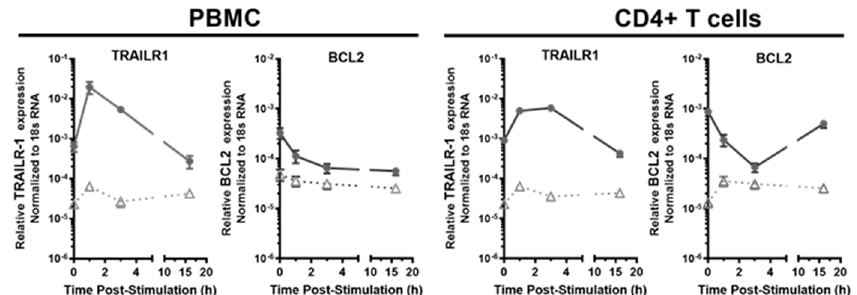
Figure 4. The kinetics of the transcription of apoptotic genes, TRAILR-1 and BCL2 in PBMC and CD4+ T cells in response to exogenous IFN- γ . PBMC and enriched CD4+ T cells from the HESN ( • n = 12) and the non-HESN ( (cid:52) , n = 10) study participants were stimulated with IFN- γ (10 ng/mL). Total RNA was isolated at the indicated time, following stimulation. Levels of nascent transcripts were assessed using RT-qPCR and normalized to 18S rRNA levels.